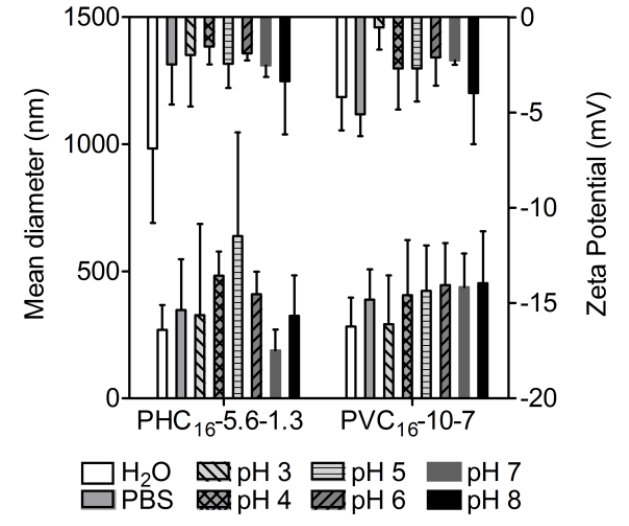
Figure 9. Influence of pH on the size and zeta potential of pullulan-C at 37 ºC in DLS (mean ± S.D., n =